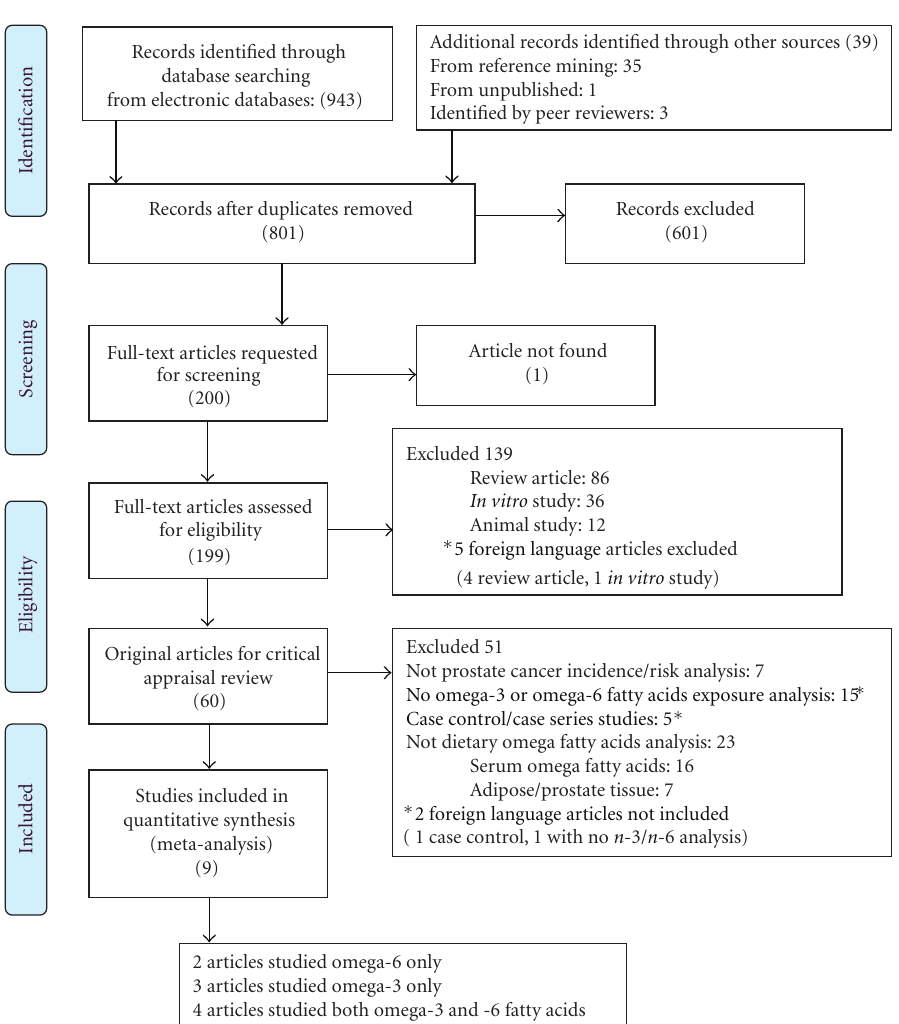
Figure 1: PRISMA diagram flow of literature search and study